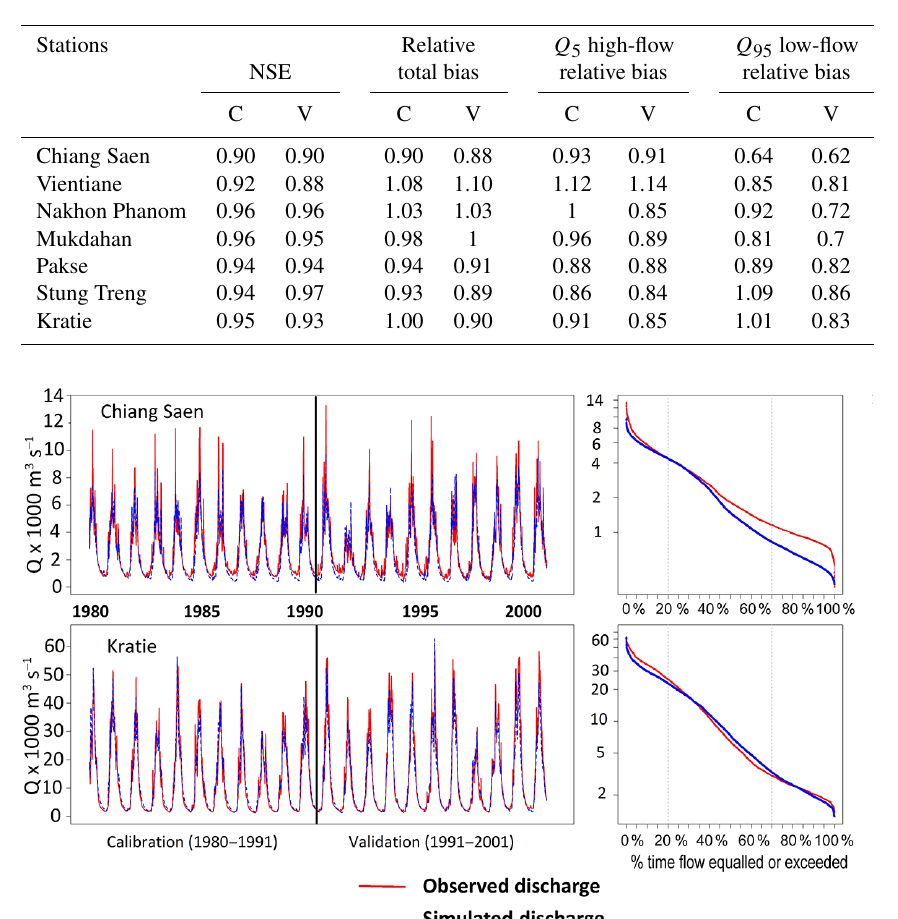
Figure 2. Daily discharge plots (left panels) and flow duration curves (right panels) during calibration and validation at Chiang Saen (upper panels) and Kratie (lower panels). See station locations in Fig.